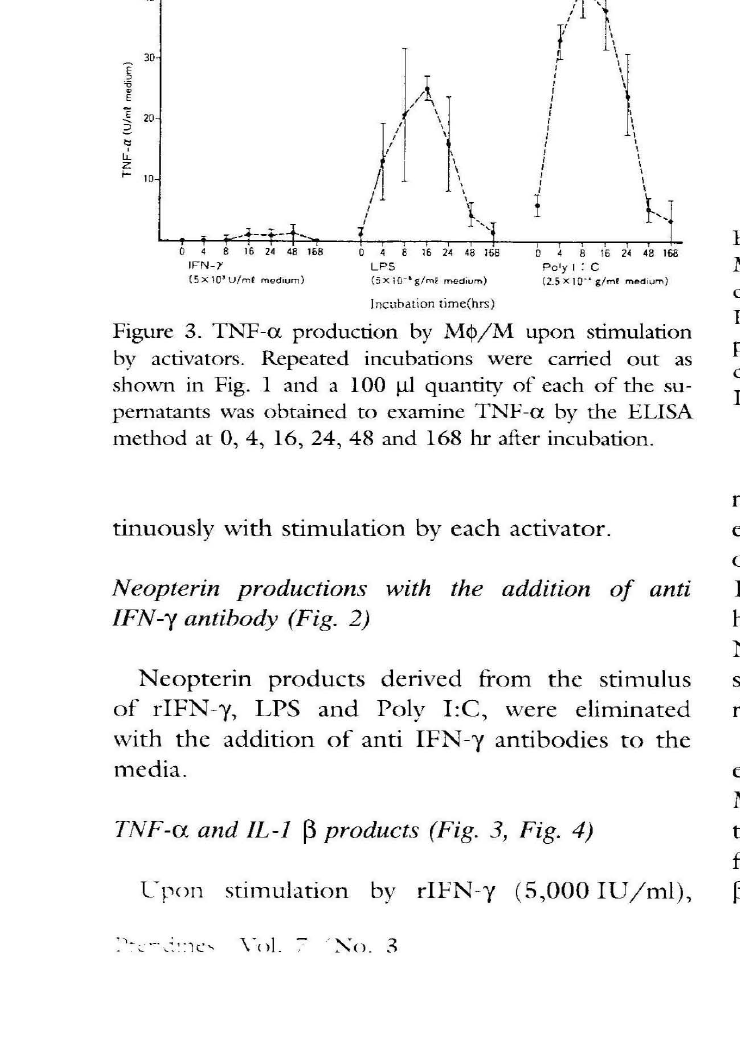
Figure 2. The addition of anti IFN-y antibody eliminated the production of neopterin. Anti IFN-y antibody (333 IU/ml) was added to the medium with an activator simul taneously. The incubation time was 7 days.